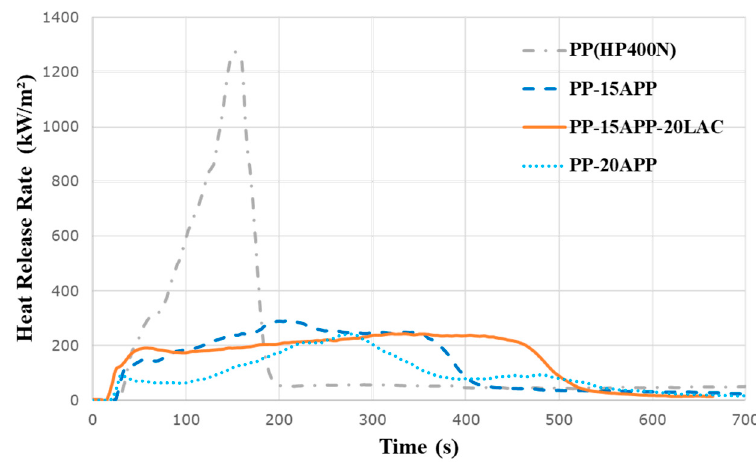
Figure 7. HRR curves of neat PP, PP-15% / 20% APP, and PP-15%APP-20%LAC samples. Table 4. Cone calorimeter data of neat PP, PP–casein (LAC/SC), and APP samples.